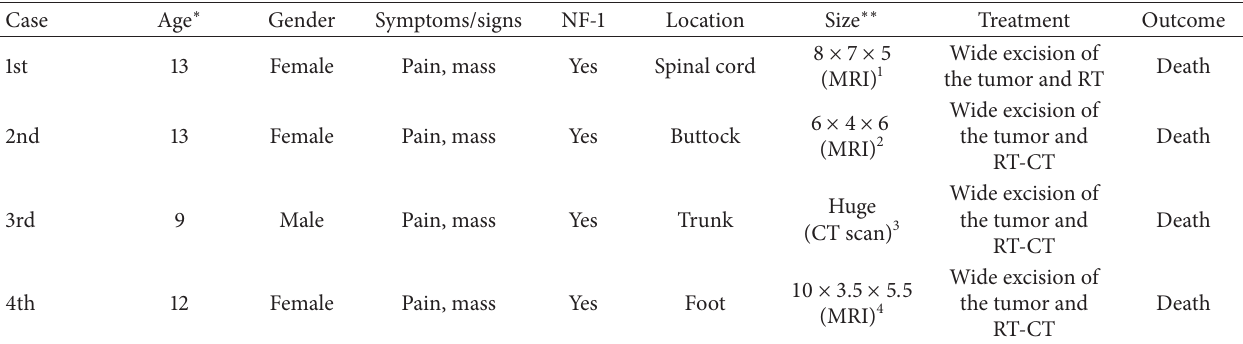
Table 1: Characteristics, treatment, and outcome of patients.